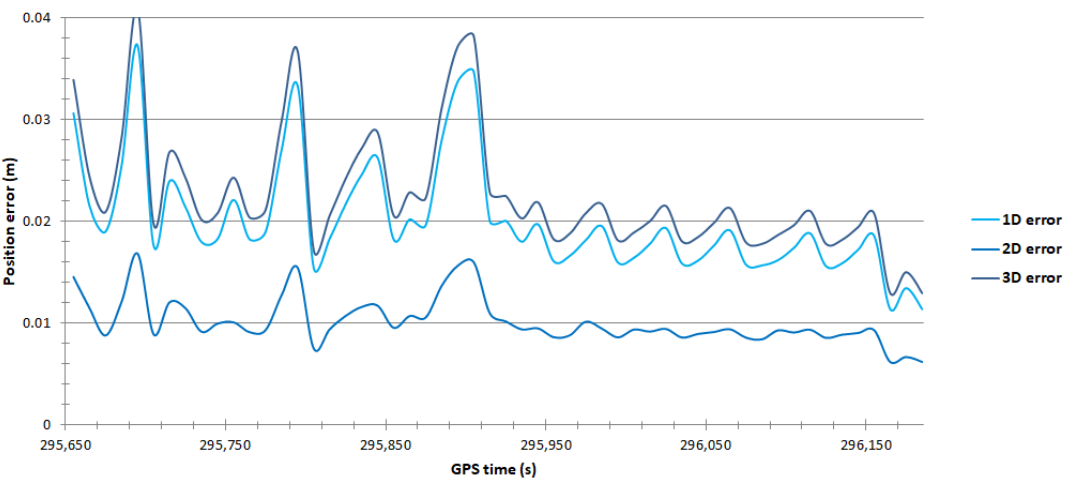
Figure 9. Variability in position errors recorded by the GNSS/INS system in the PP mode in section no. 1.